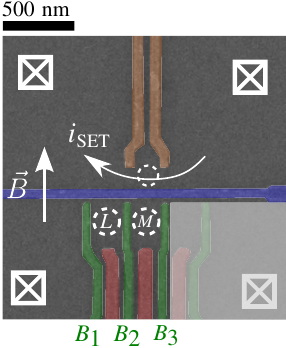
FIG. 5. Electron micrograph of a sample similar to the one measured. The three QDs (lower dashed circles) are probed via a local electrometer (top dashed circle). The green gates mainly control the dot-dot and dot-reservoir tunnel rates. The red gates are biased with negative voltages to prevent leakage between the gates. Four electron reservoirs are located at the white crossed squares and are used to either load electrons in the QD array for the bottom ones or apply a bias through the SET for the top